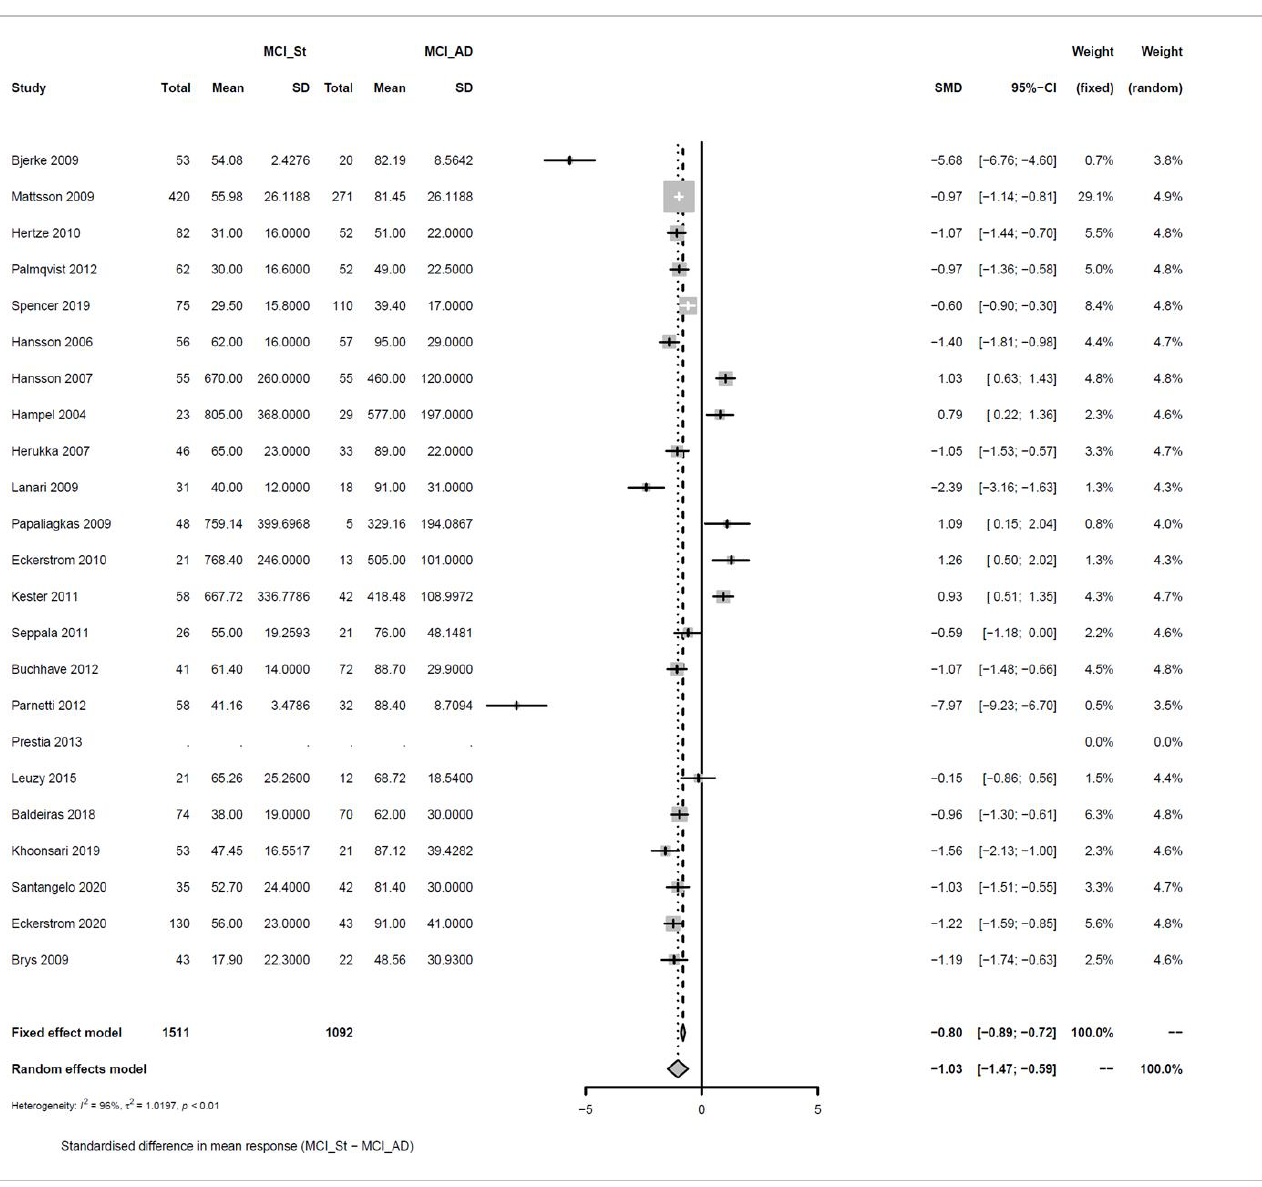
Figure 11. Meta-analysis of studies investigating CSF P-Tau levels for non-progressive MCI (MCI_St) versus progressive MCI (MCI_AD), see Appendix A.4.1 [30,32,34 – 37,44 – 48,50,54,55,57,58].